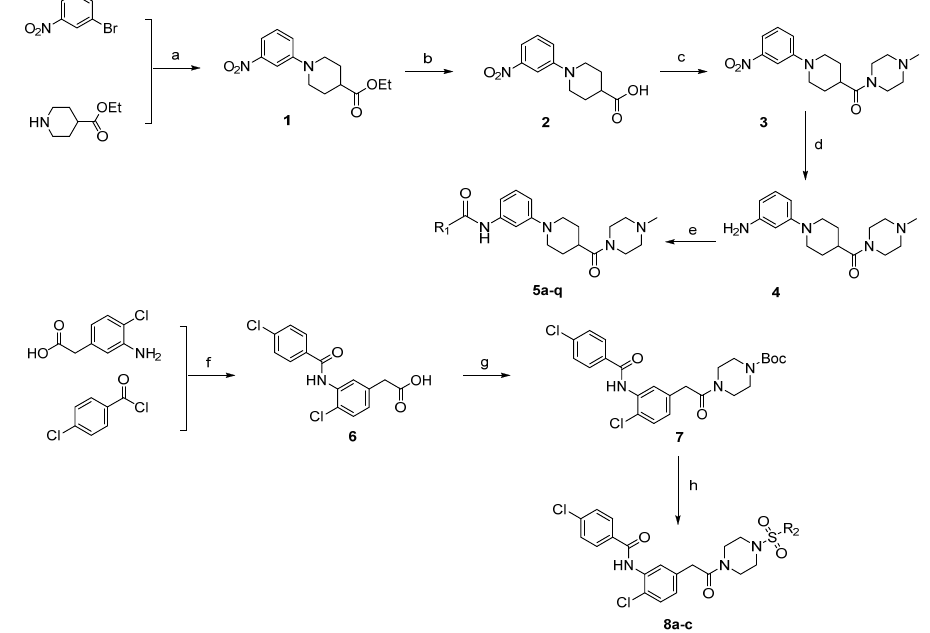
Table 1. The structures and the hedgehog pathway inhibition of target